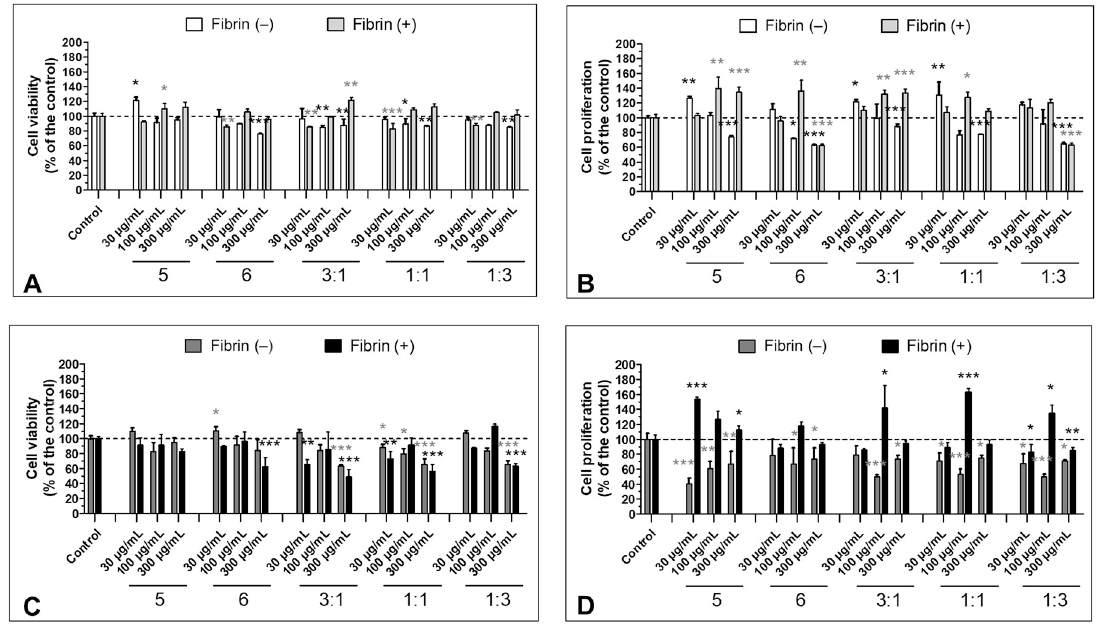
Figure 5. Effect of S5 and S6 on the viability and proliferation of CCD 841 CoTr and HT-29 cells (MTT method). The viability of the CCD 841 CoTr ( A ) and HT-29 ( C ) cells was slightly decreased by the S5 and S6 fractions; moreover, a stronger effect was exerted by the fractions administered in the combinations. The effect was independent of the presence of the fibrin clot. In turn, the proliferation of the normal ( B ) and cancer cells ( D ) was affected by the presence of the clots to a greater extent. Fibrin exerted a protective effect against S5 and S6 fractions, especially those administered at 100 µ g/mL. However, the lower (30 µ g/mL) and higher (300 µ g/mL) concentrations had a strong proliferation-inhibiting effect towards cancer cells and proliferation-inducing effect on normal cells. * p < 0.05; ** p < 0.01; *** p < 0.005; one-way ANOVA, n = 3, post hoc: Dunnett’s